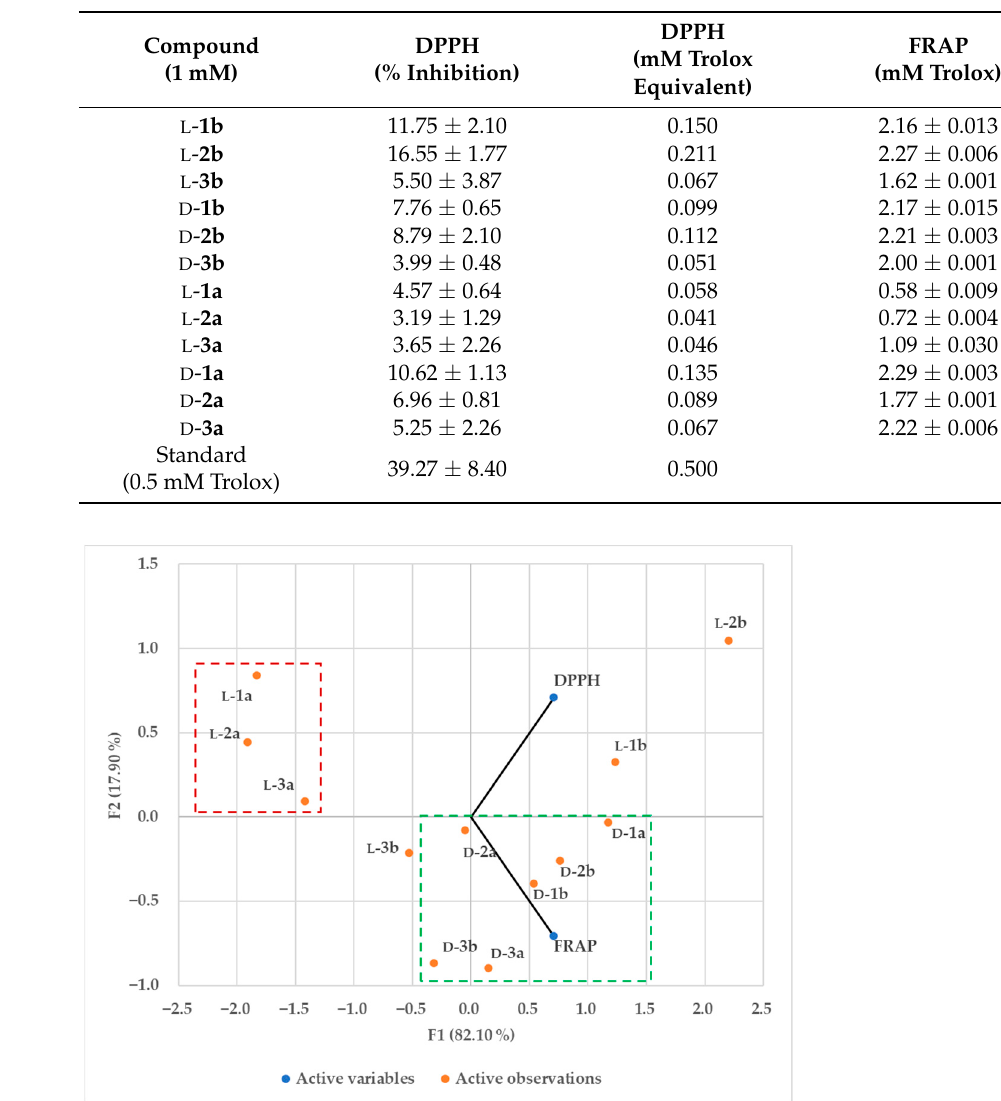
Table 3. Antioxidative activity of ferrocene compounds evaluated using free 1,1-diphenyl-2-